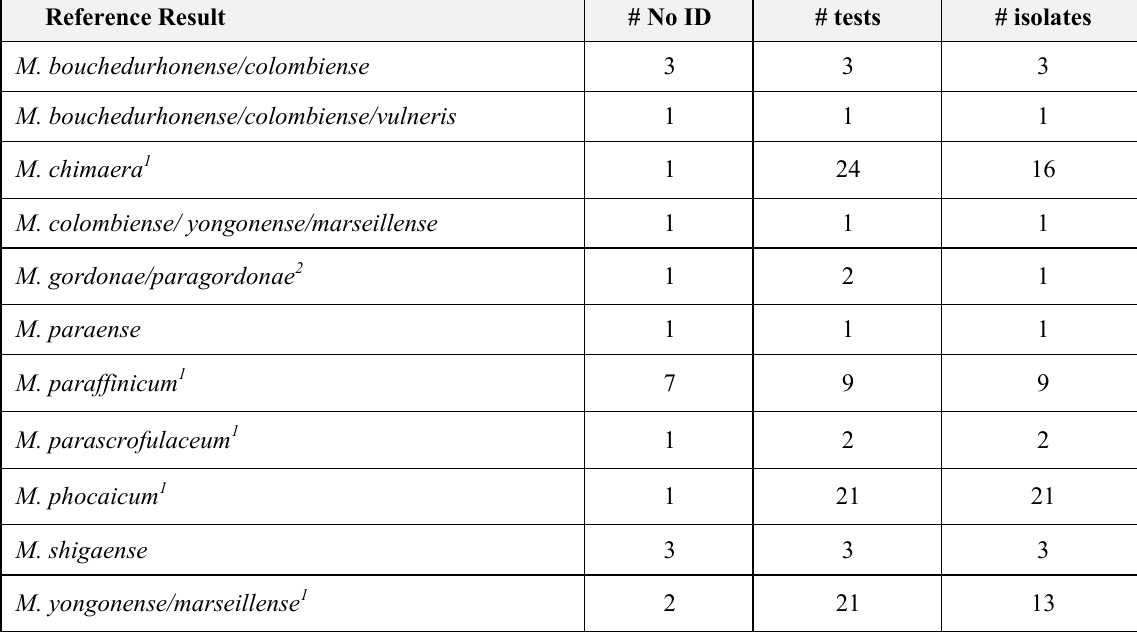
TABLE 7: Mycobacteria species tested; VITEK MS result ‘No Identification’ Reference Result